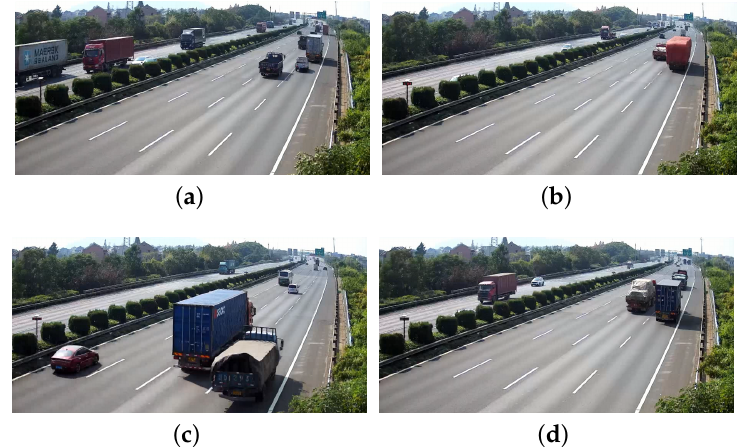
Figure 17. The real situation of the four scenes: ( a ) Scene4; ( b ) Scene5; ( c ) Scene6; and ( d ) Scene7.